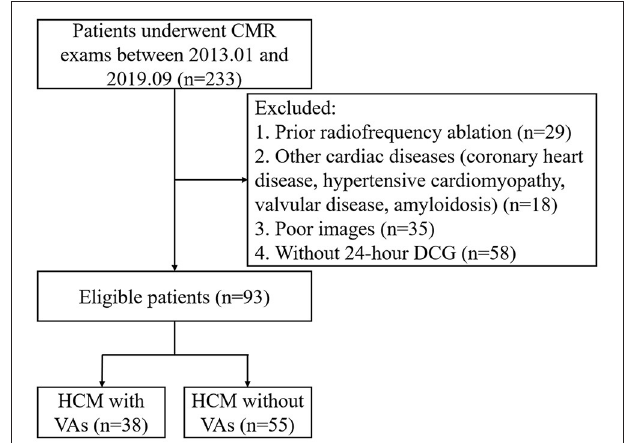
FIGURE 1 | Flow diagram showing the selection and group of HCM patients. CMR, cardiac magnetic resonance; DCG, dynamic electrocardiogram; HCM, hypertrophic cardiomyopathy; VA, ventricular